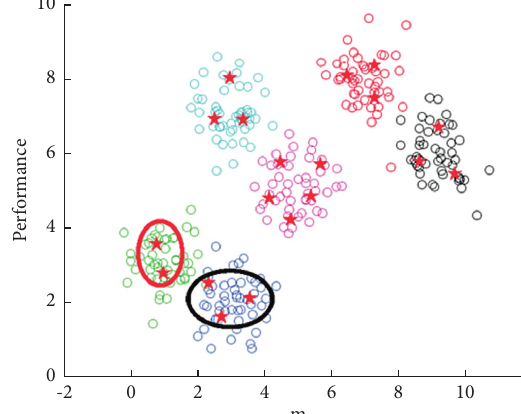
Figure 10: Performance of the test using Minimax-FCM on data set.